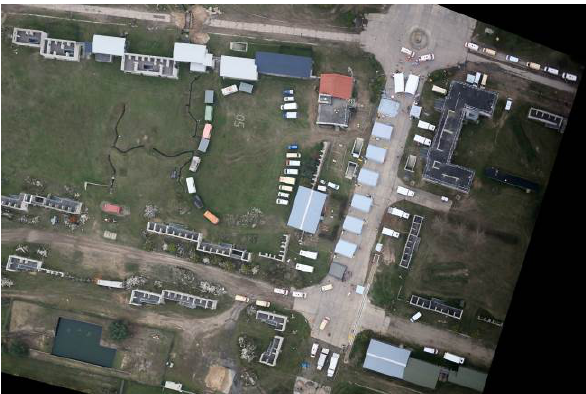
Figure 8: Aerial image acquired by the 4k camera system during the